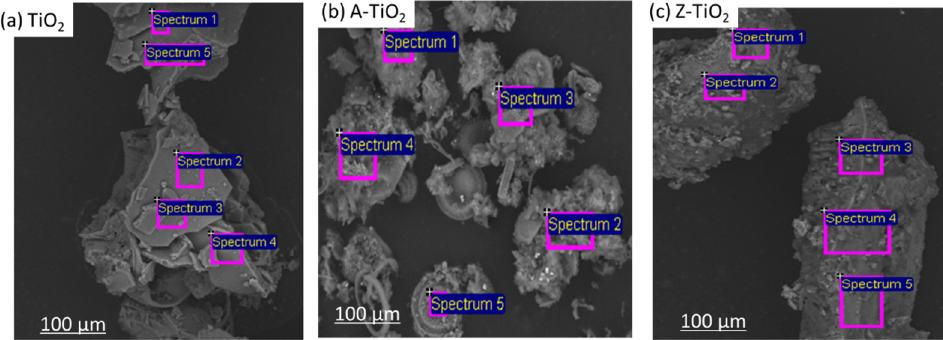
Figure 3. EDX images of ( a ) TiO 2 , ( b ) A–TiO 2 and ( c ) Z–TiO 2 . Table 1. Elemental distribution of TiO 2 , A–TiO 2 , and Z–TiO 2 for their average spectra (Figure 3).